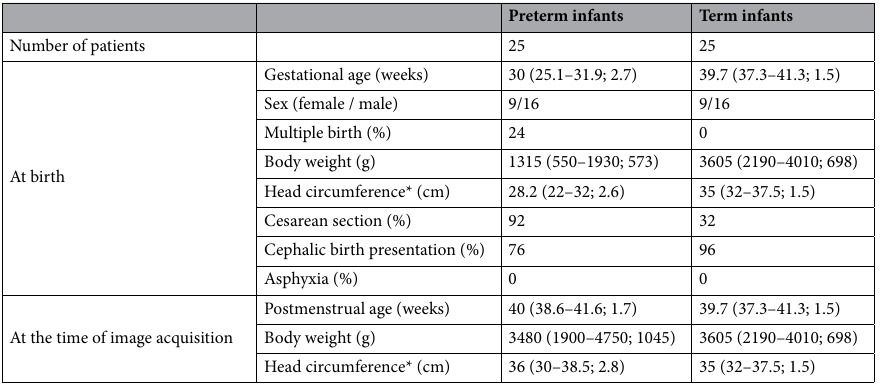
Preterm infants Term